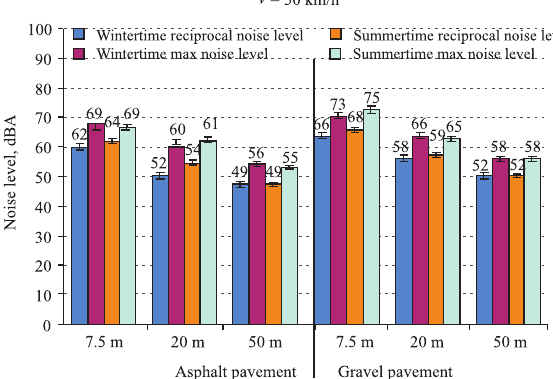
Fig. 6. Th e reciprocal and the max noise levels of a car driving